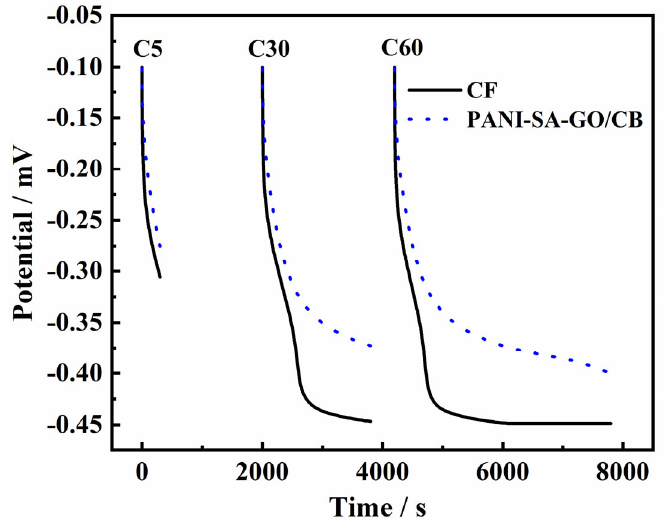
Figure 4. Time–potential tests of MFCs with two anodes. (The MFCs were under open circuit condition). Figure 5a–c show the discharge curves of two anodes at the control potential − 0.1 V. As is shown, all the discharge curves showed a peak current (i h ) at the beginning of the discharge test, followed by a rapid current decay until it approached a relatively constant value (i s ). The peak current density was highly dependent on the specific